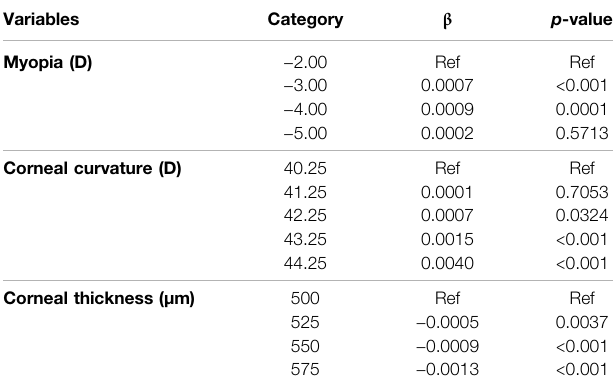
TABLE 6 | Quantile regression results of central corneal stress and independent variables.